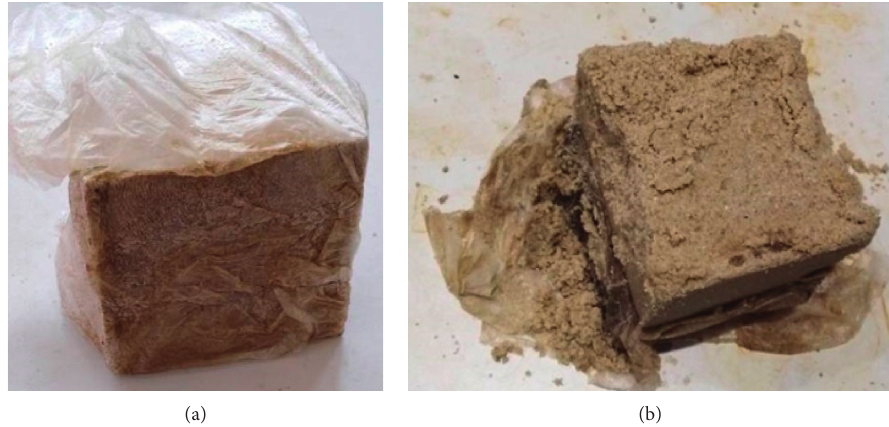
Figure 3: Sample (a) before and (b) after the test.